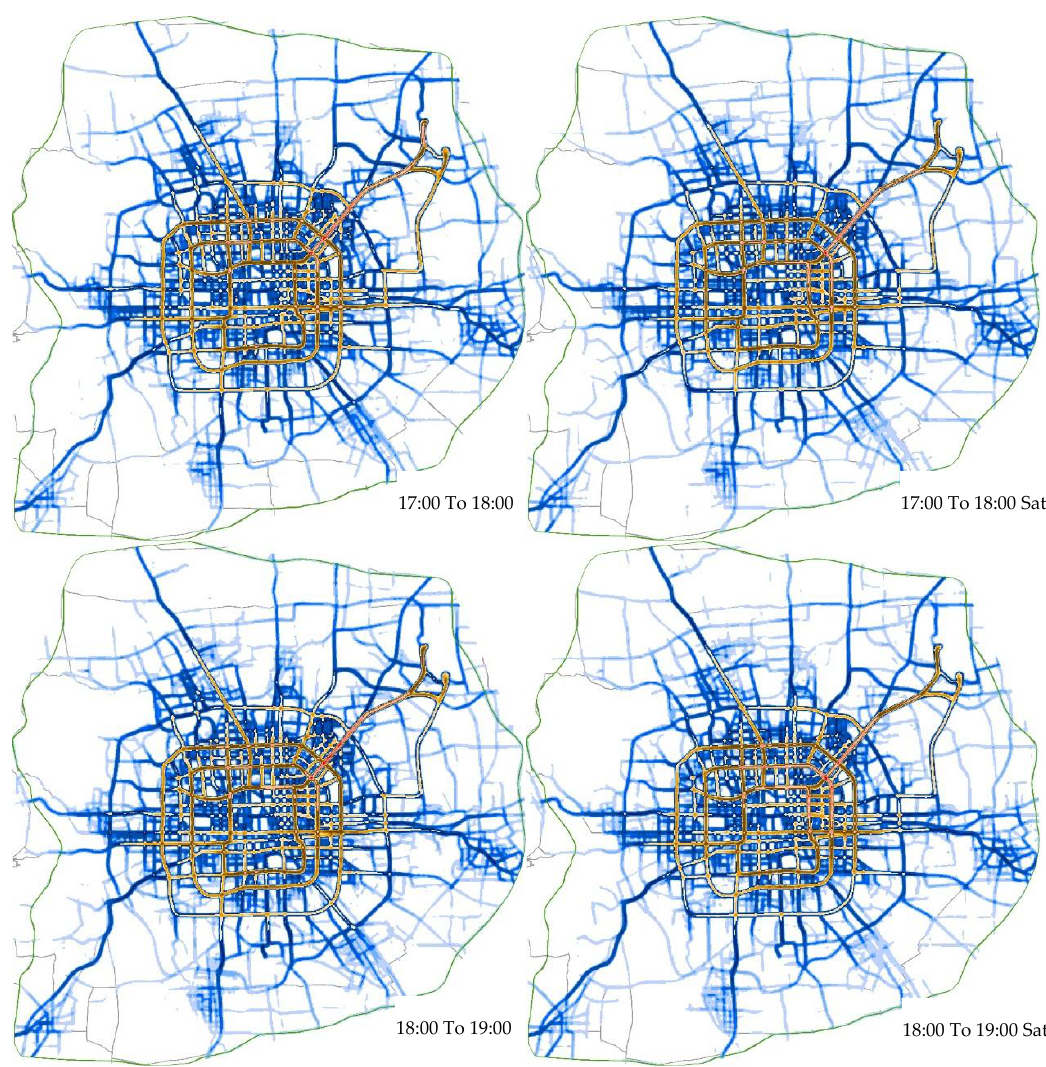
Figure 15. Spatial comparison of carbon emissions between weekdays and weekends.